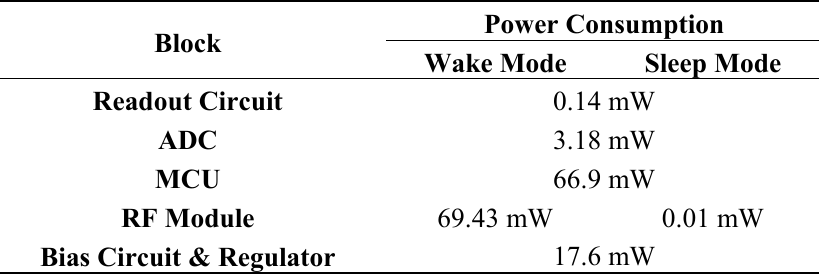
Table 4. Power consumption of each